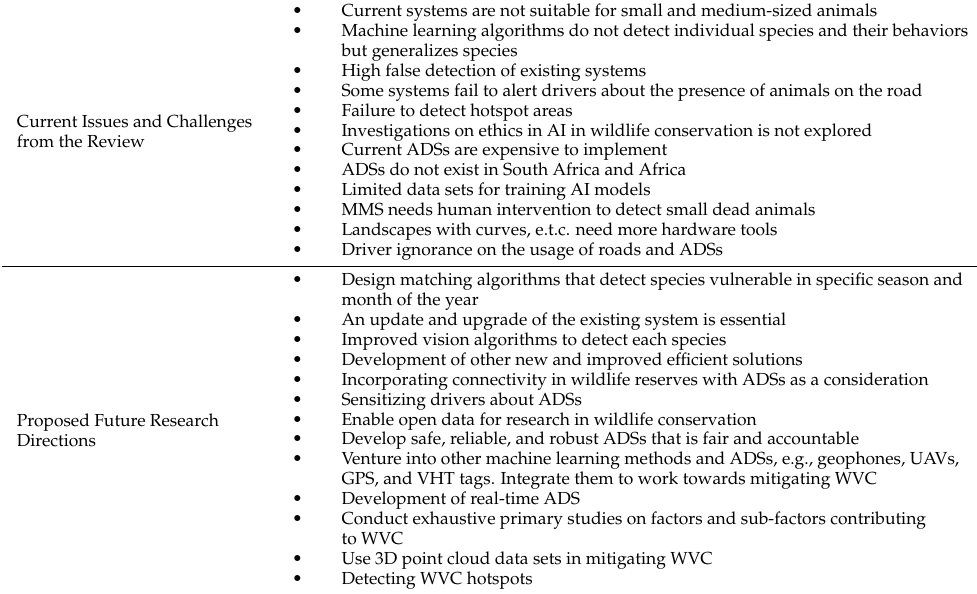
Table 11. Summary of issues, challenges, and future research